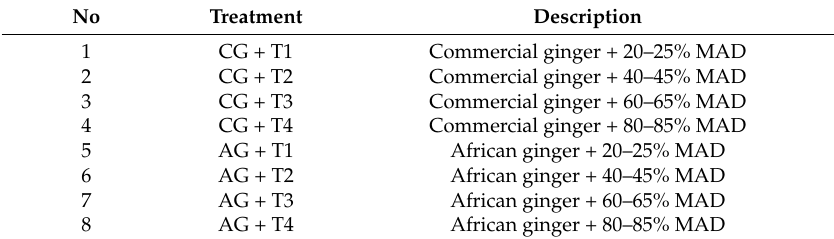
Table 4. Ginger × Irrigation treatment combinations used in the